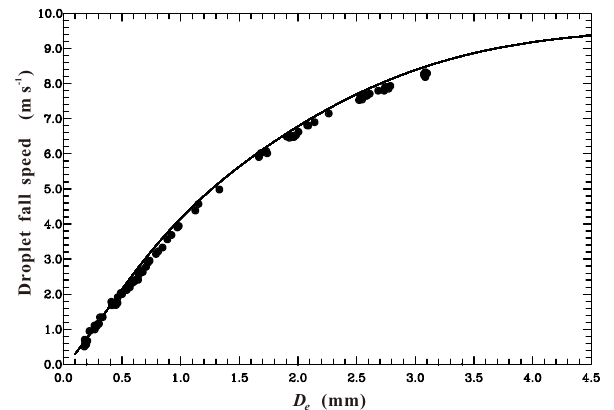
Figure 6. Size and velocity distribution of 95 analyzed drops col- lected from the indoor experiment. Each black dot represents a drop. The theoretical curve of V t (Eq. 2) is also superposed on the analysis